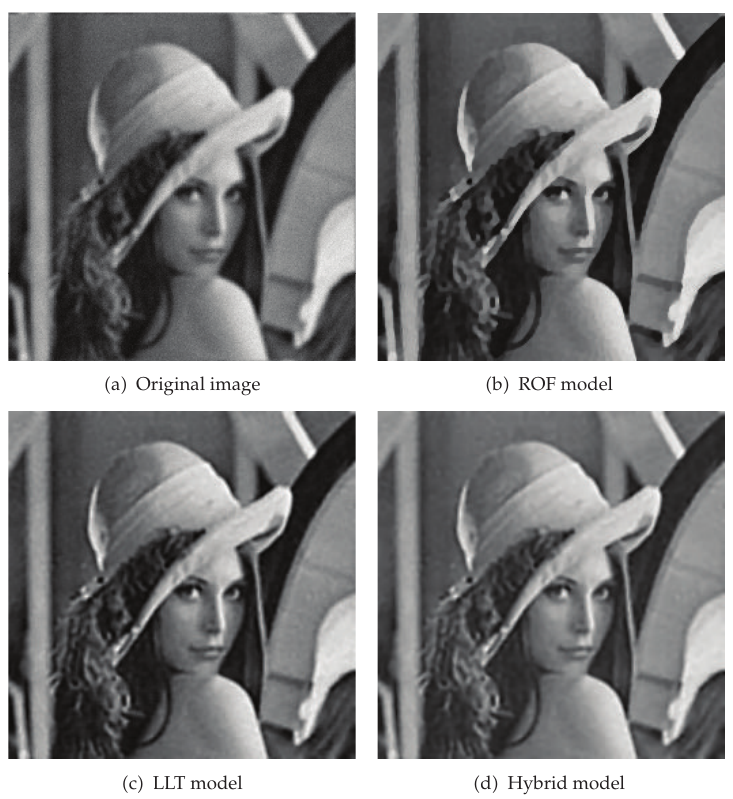
Figure 4: The related SNRs in Example 4.11. (cid:3) a (cid:4) 11.2166; (cid:3) b (cid:4) 14.3378; (cid:3) c (cid:4) 14.4778; (cid:3) d (cid:4)